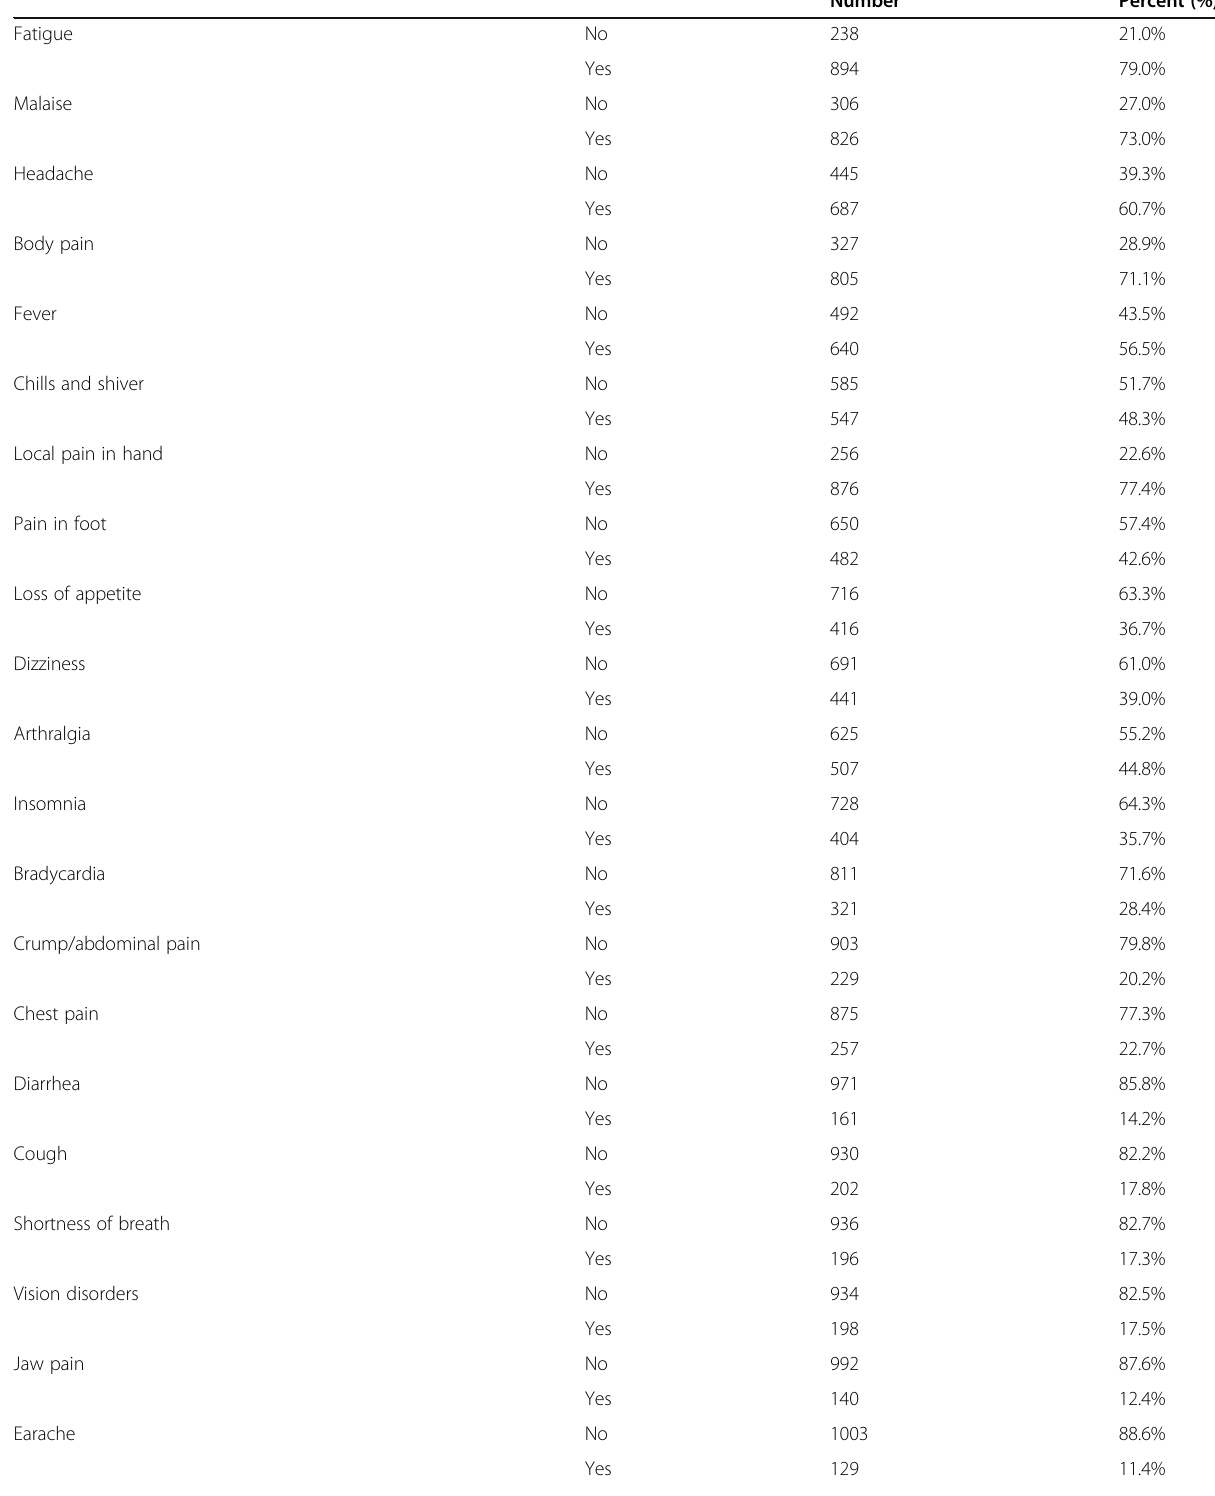
Table 2 Frequency of side effects in